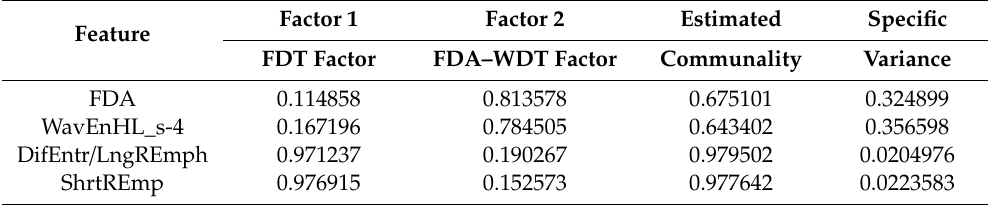
Table 4. Factor loading matrix after varimax rotation.